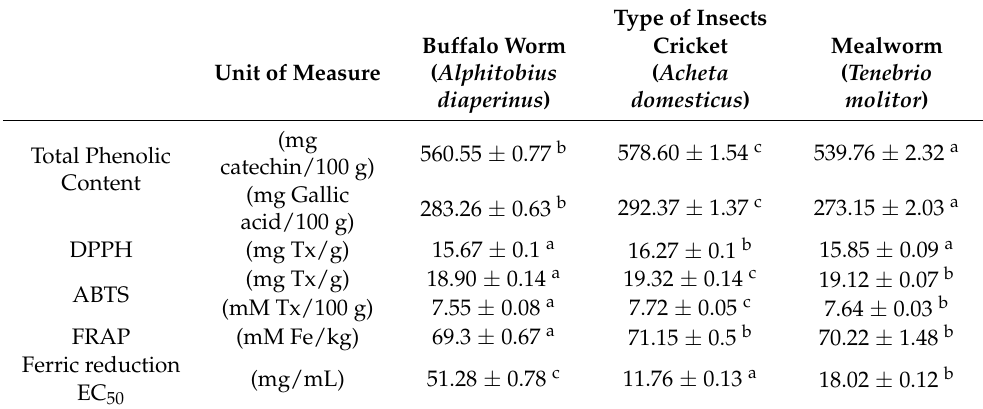
Table 4. Contents of polyphenols and antioxidant activities of flours from edible insects.